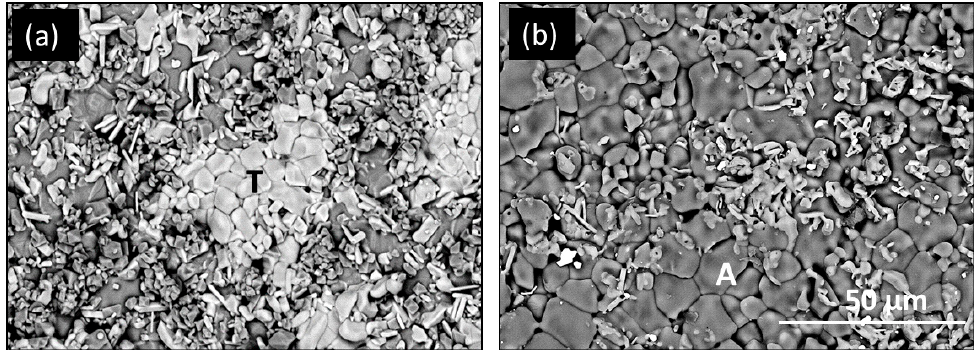
Figure 5. SEM/BSE surface microstructures of scales formed on Ti 2 AlC at 1300 °C in ( a ) furnace pre-oxidation for 300 h and ( b ) followed by high pressure burner rig (80 h at 6 atm, 25 m/s). T (Ti-rich transient scale); A (Al 2 O 3 ) [13].